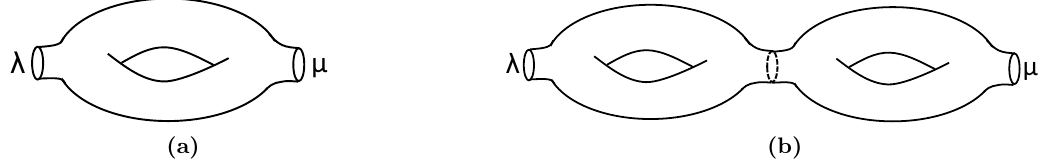
Figure 3. ( a ): we associate C (1) (cid:22) to a genus one surface with an in-boundary and out-boundary. (cid:21) (cid:21) at the in-boundary and (cid:22) at the out-boundary denote the lower and upper indices of C (1) (cid:22) respectively. ( b ): a contraction P C (1) (cid:22) (cid:23) C (1) (cid:23) corresponds to gluing two genus one surface with an (cid:23) (cid:21) in-boundary and out-boundary, which is a genus two surface with an in-boundary and out-boundary and is expressed by C (2) (cid:22) (cid:21)